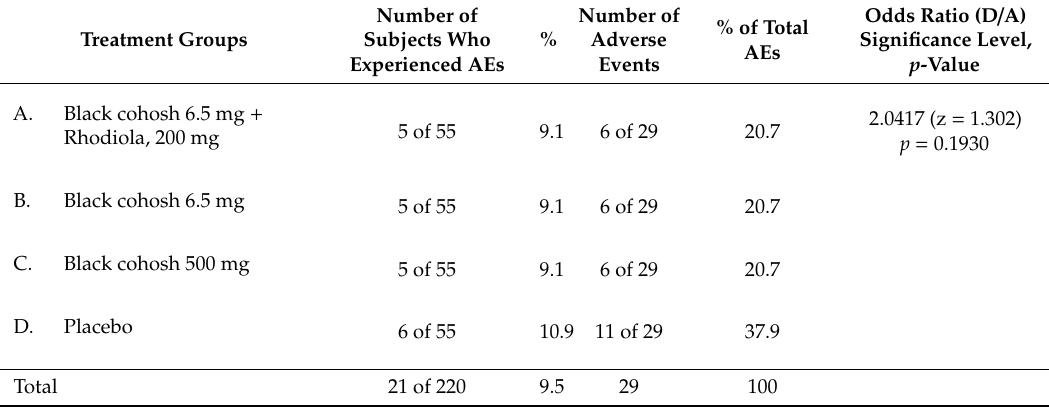
Table 3. Number of patients who experienced adverse events (AE) and the number of AEs in each treatment group.